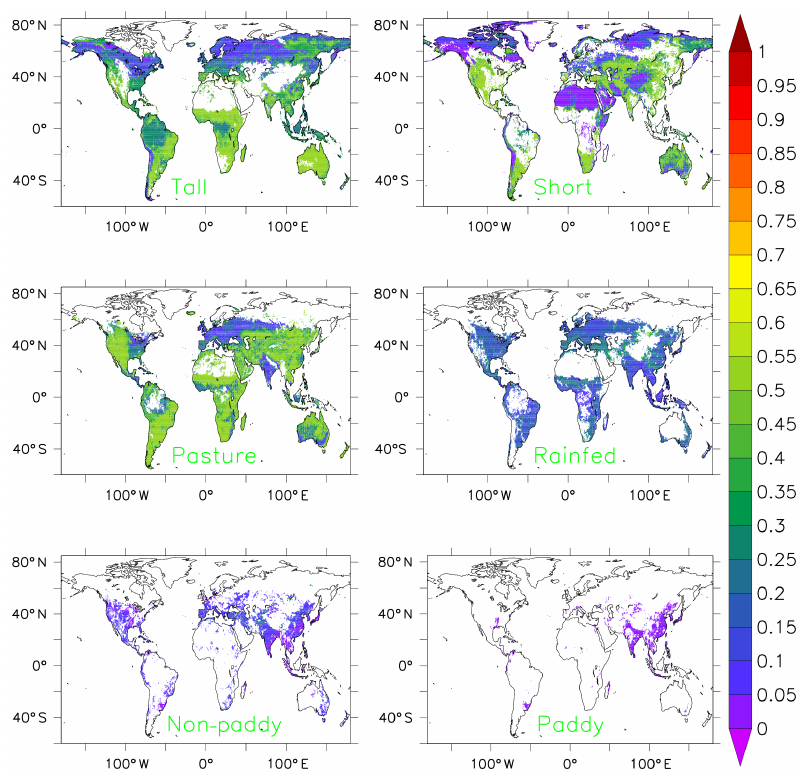
Figure A4. Root fraction in soil layer 2 (lower soil layer, reaching 0.52 to 1.2m depth) in LC2000 per land cover type, used to compute land-cover-specific transpiration. The higher the root fraction, the more root is in the lower soil layer (and thus able to pick up moisture from both layers). Values are given where a land cover type covers more than 1% of a grid cell.